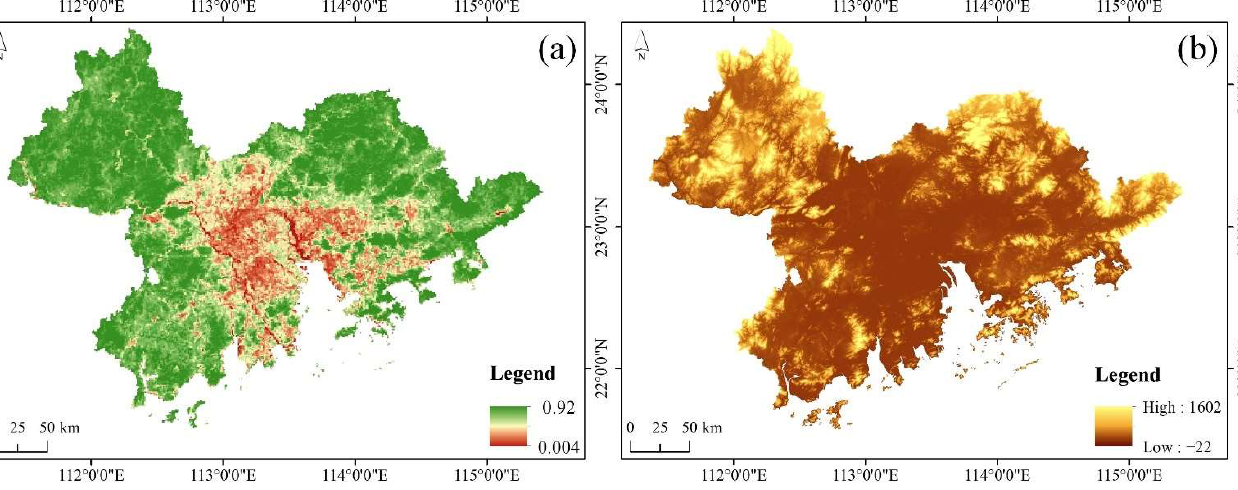
Figure 2. The distribution of NDVI ( a ) and DEM ( b ) in the GBA.